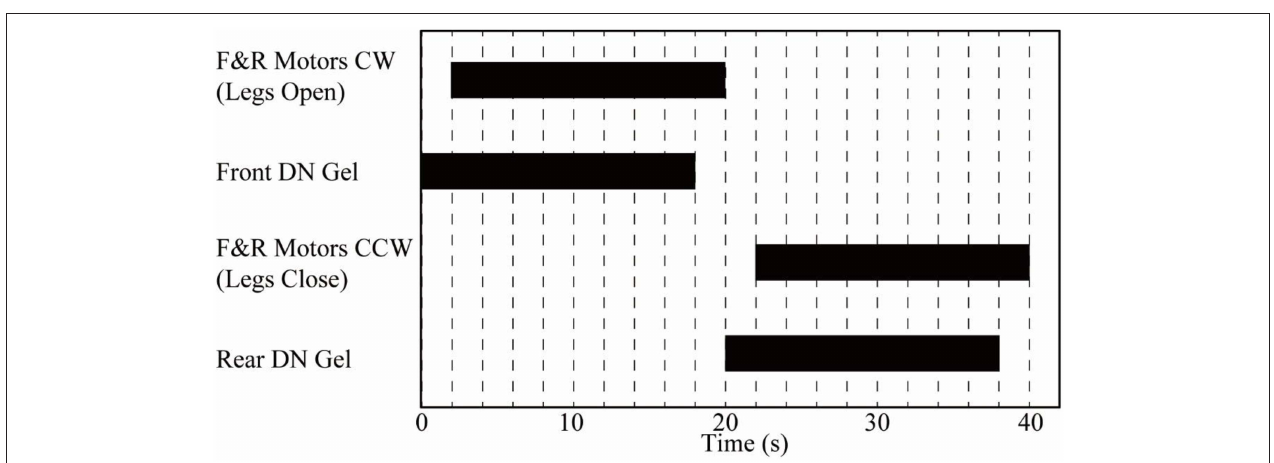
FIGURE 6 | Gait diagram of the inchworm search robot for one step of its walking motion.